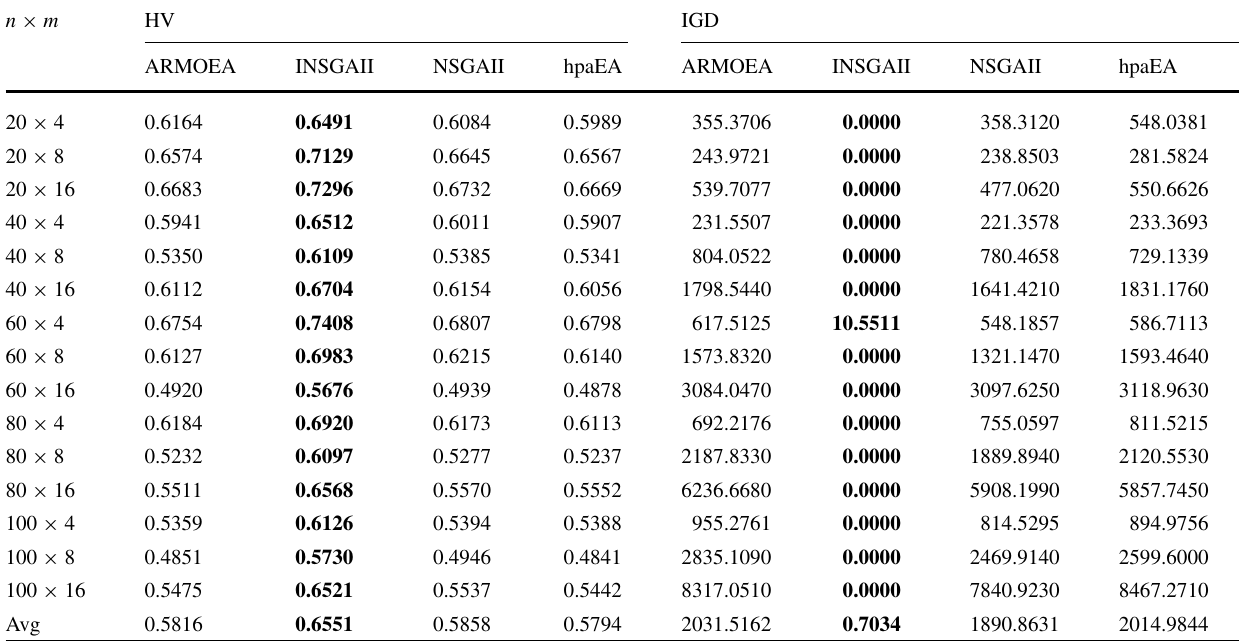
Table 13 Results of the algorithms ( g (cid:2)